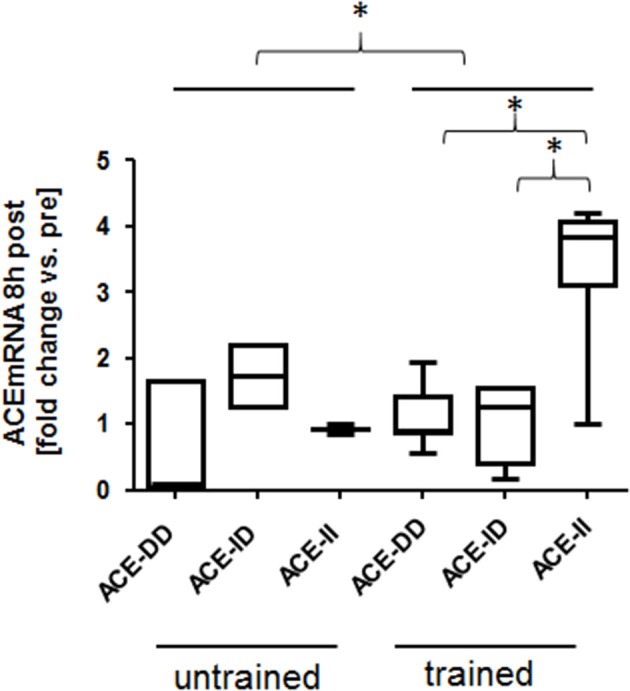
Effect of ACE-I/D genotype and training status on ACE transcript expression post exercise. Box-and-whisker plot of fold alterations in ACE transcript levels between the trained and untrained subjects, 8 h post- vs. pre-exercise, in each ACE-I/D genotype. *p < 0.05 for the indicated comparison. ACE-II. Univariate ANOVA with post hoc test of Fisher.